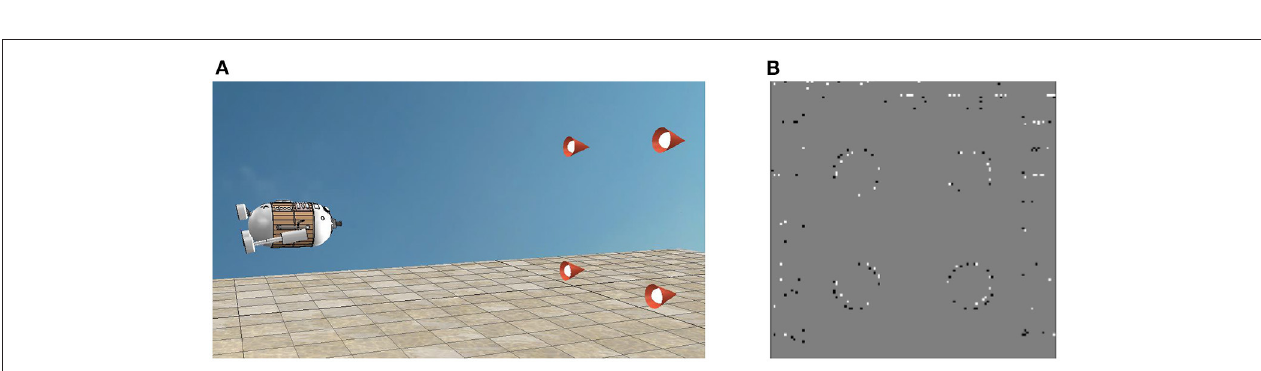
FIGURE 4 | (A) AUV and targets in V-REP. (B) Events of targets in V-REP.